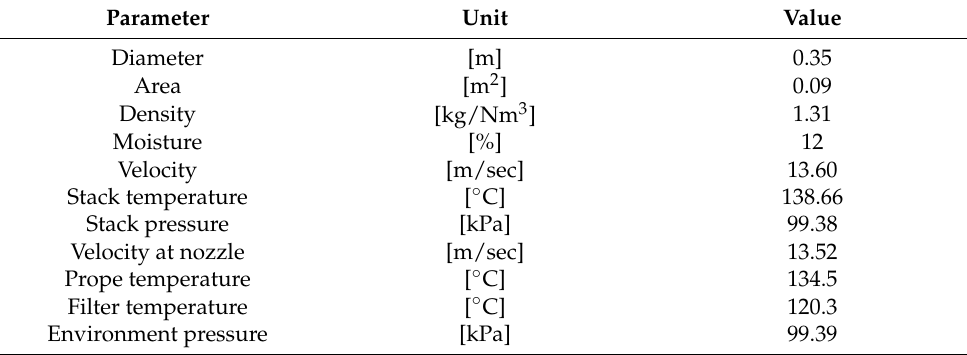
Table 2. Stack sampling parameters and operative